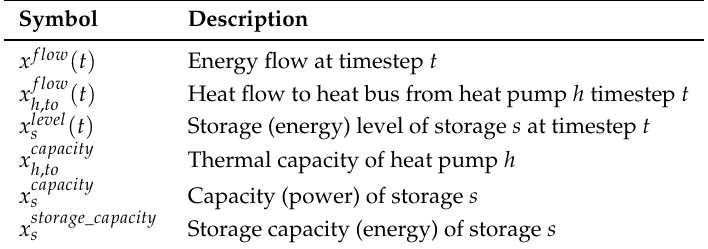
Table A2. List of optimisation variables in the model.